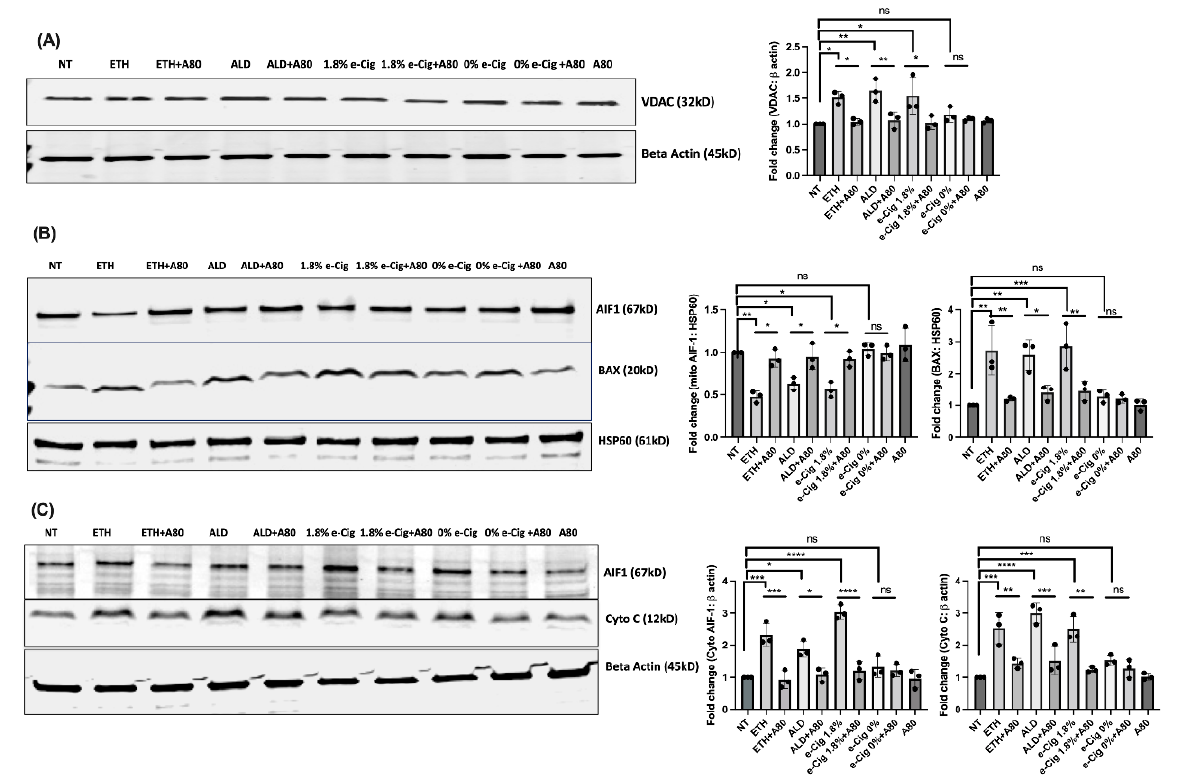
Figure 5. P2X7r antagonist (A804598) protected the mitochondrial function against ETH, ALD, and 1.8% e-Cig stimuli. ( A ) ETH stimulation increased the VDAC levels by fifty percent (50%), whereas ALD and 1.8% e-Cig stimulus doubled the VDAC expression. ( B ) Mitochondrial fractions from hBMVECs exposed to ETH, ALD, and 1.8% e-Cig showed a three-fold increase in BAX protein levels. Simultaneously, levels of AIF-1 proteins deteriorated by 50% with ETH, 55% after ALD, and up to 60% after 1.8% e-Cig exposure. ( C ) In parallel, cytosolic fractions presented greater AIF-1, and cytochrome C levels in response to the insults. hBMVECs treated with A804598 (A80) critically protected the mitochondrial health and minimized the cytosolic escape of AIF-1 and Cytochrome C . Western blots from whole cell lysates, cytosolic fractions were normalized to β -actin and HSP60 for mitochondrial fractions ( n = 3). One-way ANOVA was used for the statistical analyses, marked as * p ≤ 0.05, ** p ≤ 0.01, *** p ≤ 0.001, **** p ≤ 0.0001 and ns (not significant).